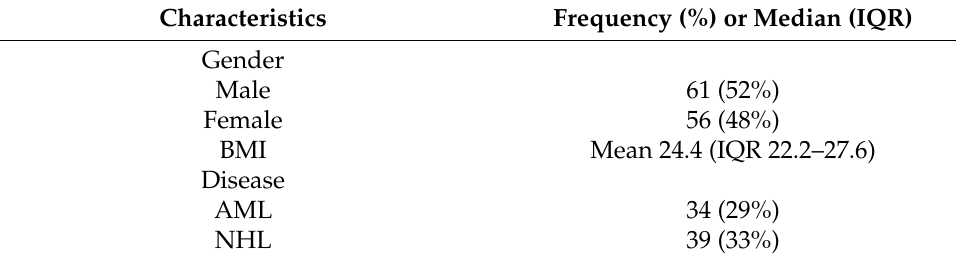
Table 1. Patient